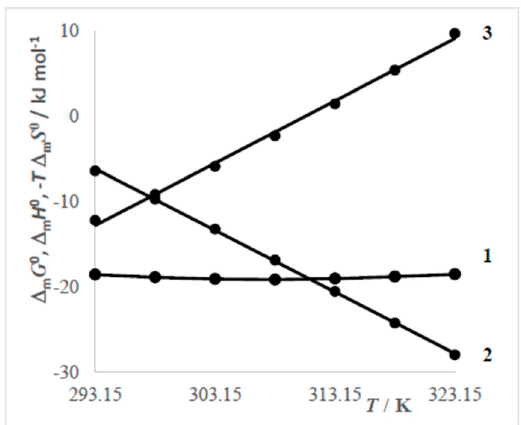
Figure 8. Dependences thermodynamic values on temperature of surfactant V-DDBDMACl: 1— ∆ m G 0 , 2— ∆ m H 0 a 3—( − T ∆ m S 0 ).